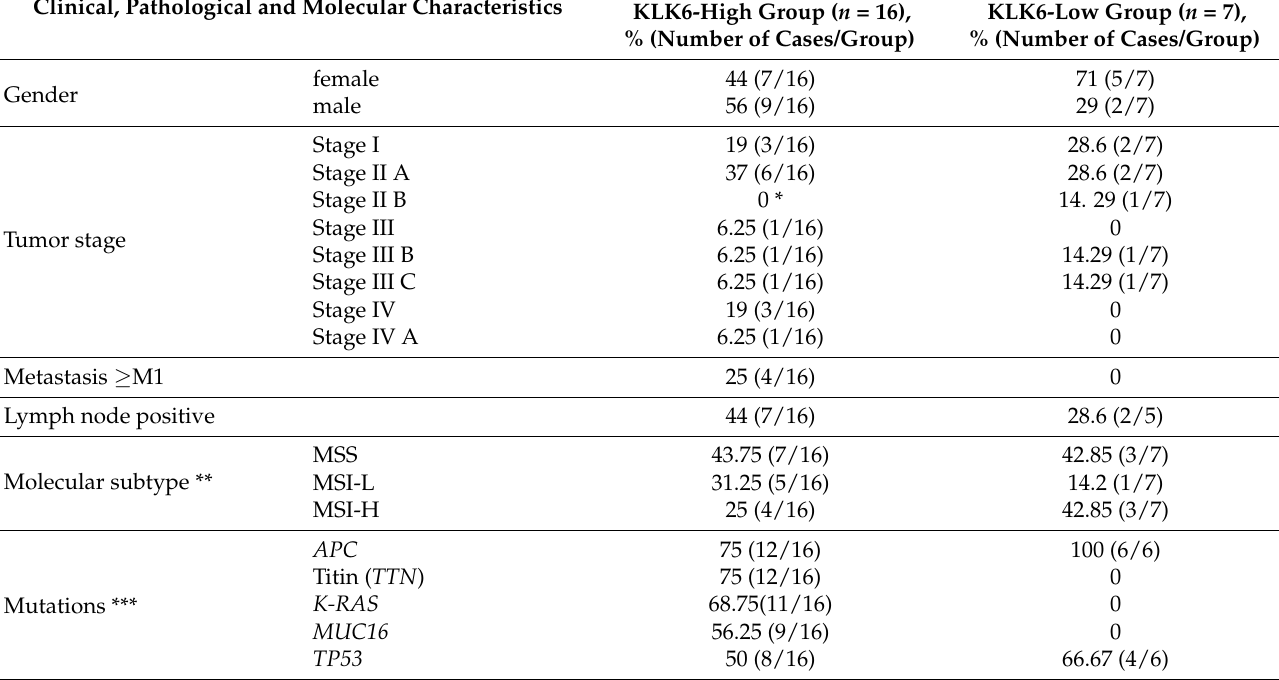
Clinical, Pathological and Molecular